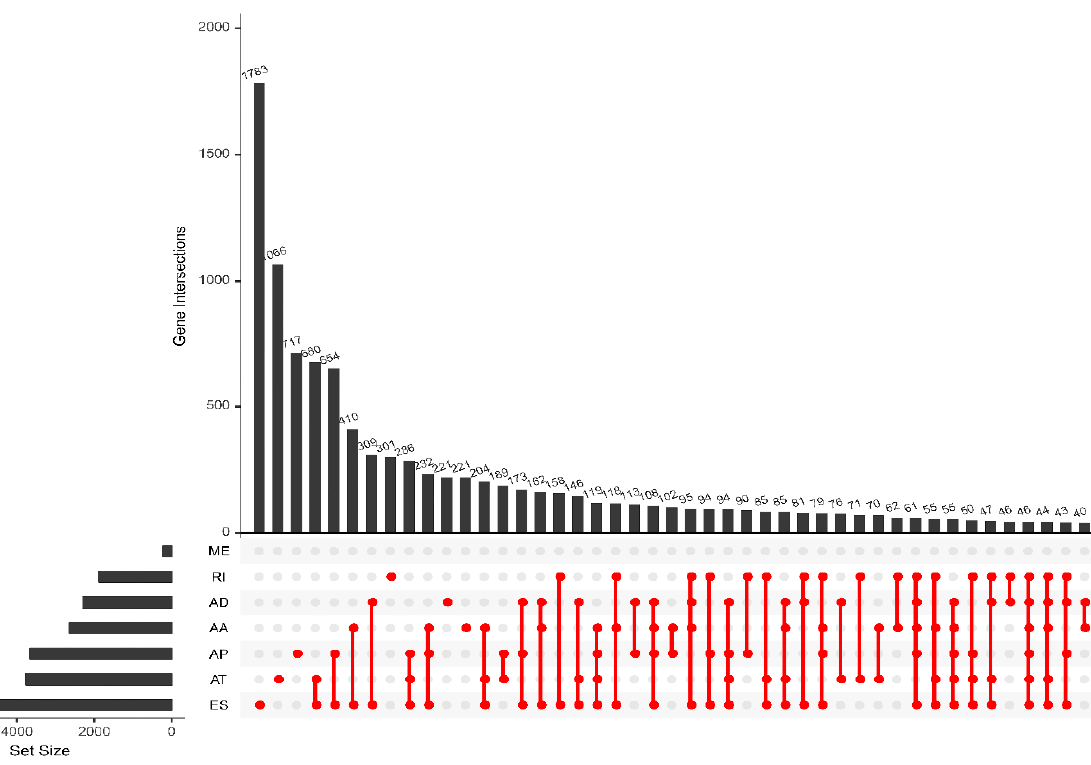
Figure 1. UpSet plots of splicing events in breast cancer. AA: alternate acceptor; AD: alternate donor; AP: alternate promoter; AT: alternate terminator; ES: exon skip; ME: mutually exclusive exons; RI: retained